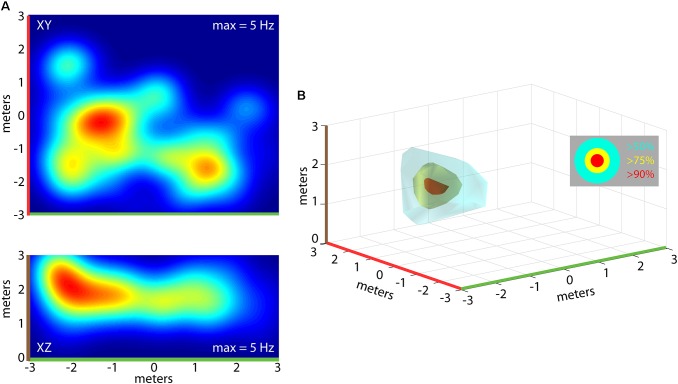
Construction of 3D place fields. (A) Top, heat map of spike rate for one neuron during an experimental flight session for Bat 1 (warmer colors = higher spike rates, max rate shown at top right of panel). Shown in the top panel is the XY projection of the neuron’s firing rate. Bottom, the XZ projection for the same neuron shown in the top panel. (B) 3D rendering of the place field for the neuron shown in (A). 3D surfaces are plotted identifying the locations in space where the neuron fired at 90% of the maximum rate (red), 75% of the maximum rate (yellow), and 50% of the maximum rate (cyan). Color highlights on axes indicate orientation of 2D heat maps in (A).